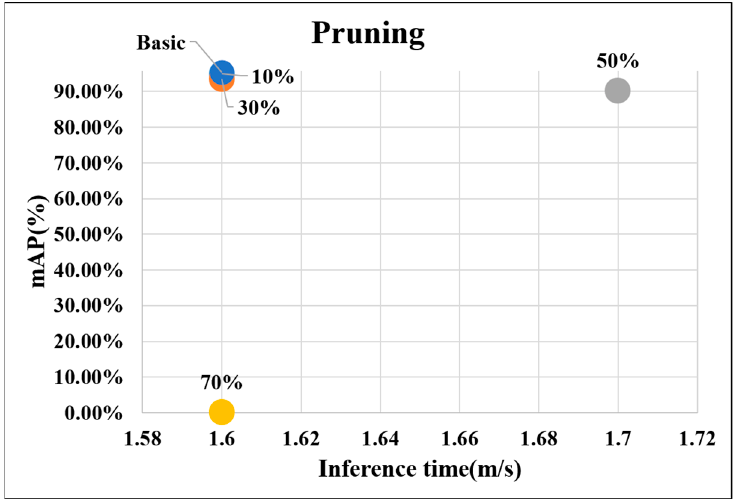
Figure 16. Result graph